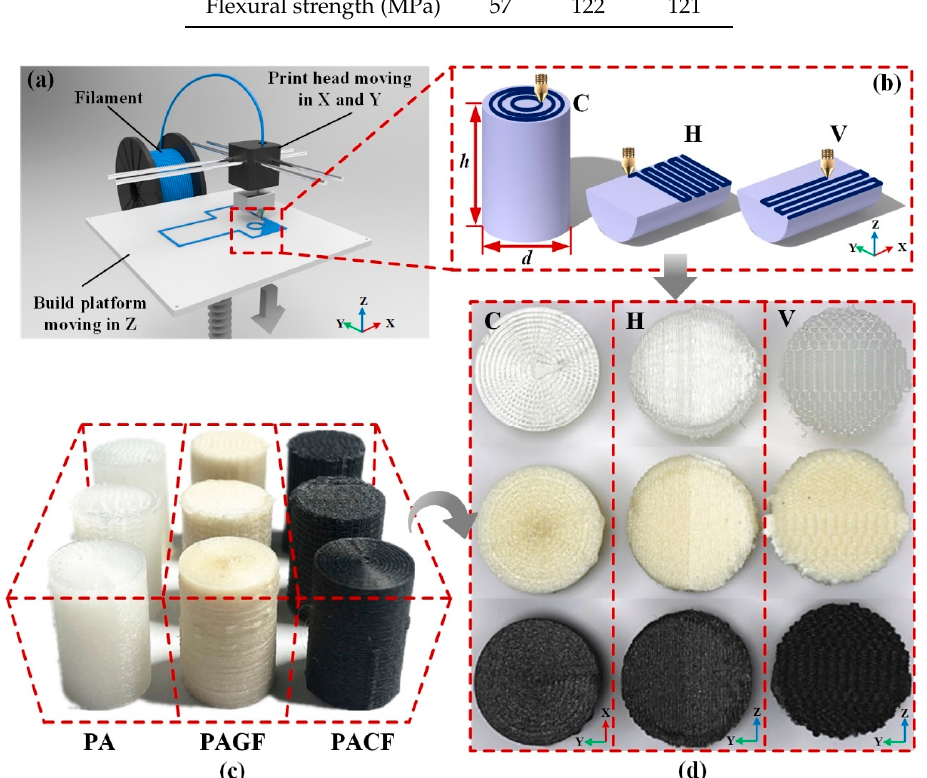
Figure 1. ( a ) Schematic diagram the fused deposition modeling (FDM) technique; ( b ) different scanning strategies in circular, horizontal, and vertical directions, ( c ) isometric view and ( d ) top